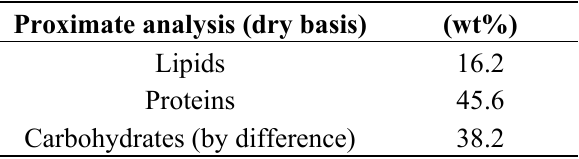
Table 2. Biochemical composition of Chlorella vulgaris biomass.